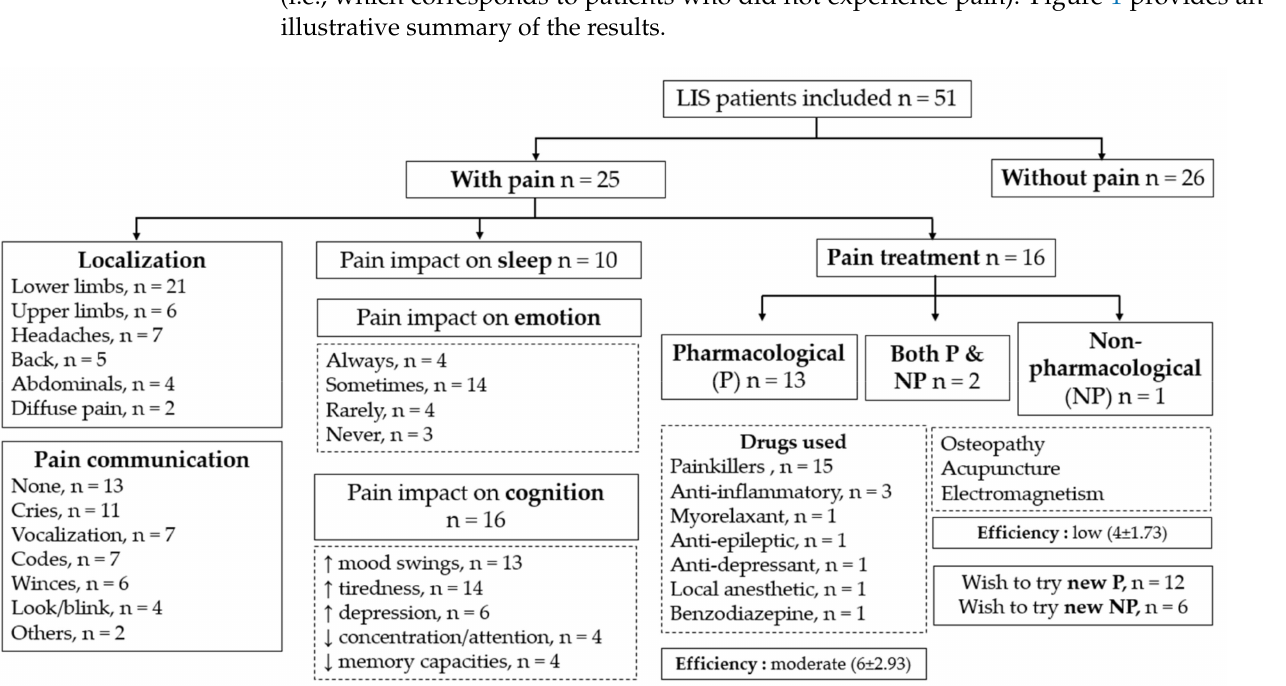
Figure 1. Summary of main results. (LIS = locked-in syndrome, P = pharmacological treatment, NP = non-pharmacological